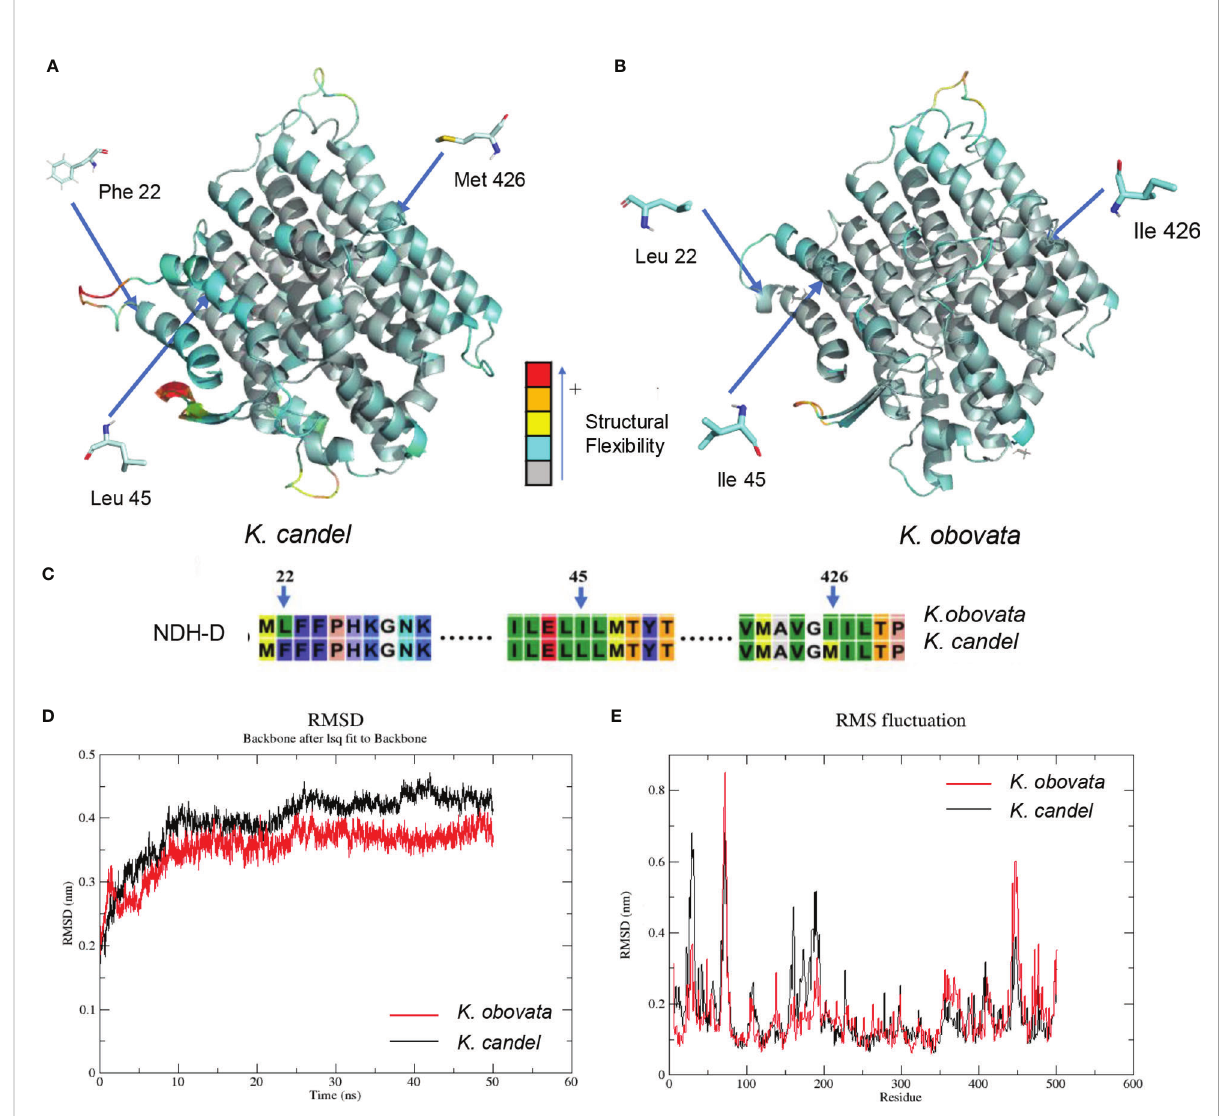
FIGURE 7 The predicated 3D structural modeling and molecular dimnamics simulation of the NDH-D protein. By setting different colors (gray to blue to yellow to orange to red) according to the b-factor values, the color in the structure is closer to red, the more fl exible the structure. (A) The 3D model of NDH-D protein for K . candel . (B) The 3D model of NDH-D protein for K . obovata . (C) The mutation sites of protein sequence compared between K . candel and K . obovata . Molecular dynamics simulations showed with RMSD (D) and RMS fl uctuation (E)